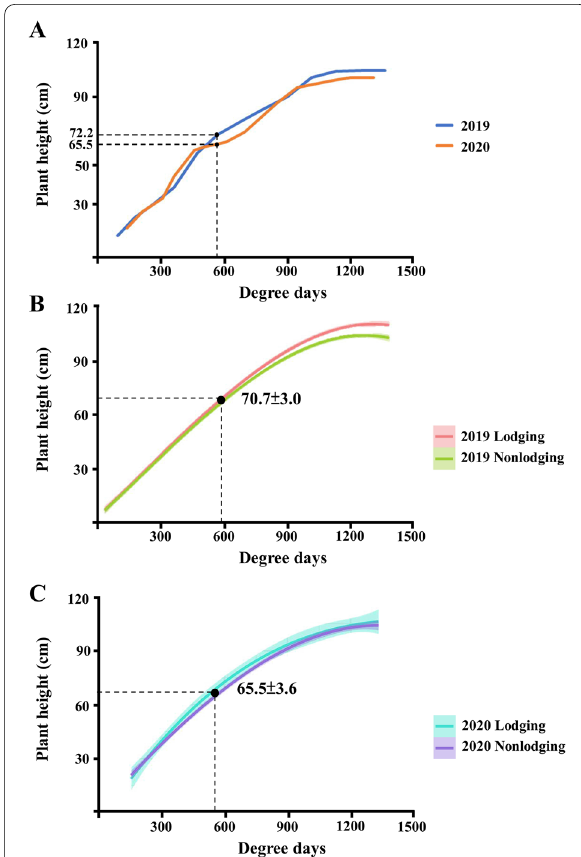
Fig. 4 Plant height development of TNG71 in 2019 and 2020. A Plant height development of rice in 2019 and 2020. B Plant height development of lodging and nonlodging rice in 2019. C Plant height development of lodging and nonlodging rice in 2020. The growing degree day is the average of the daily maximum temperature and minimum growth critial temperature (10